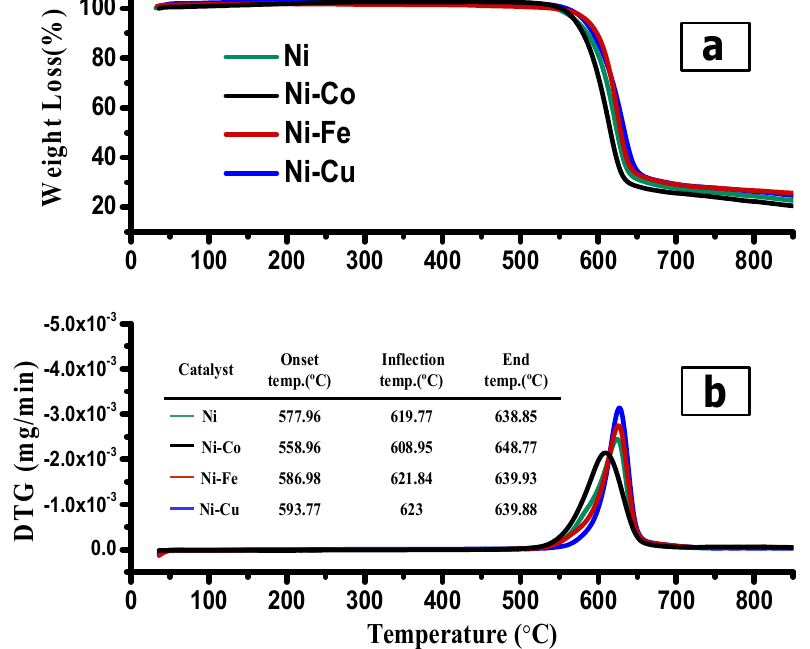
Figure 13. ( a ) TGA and ( b ) DTA analysis of the carbonous materials deposited over Ni, Ni-Co, Ni-Fe, and Ni-Cu catalysts.